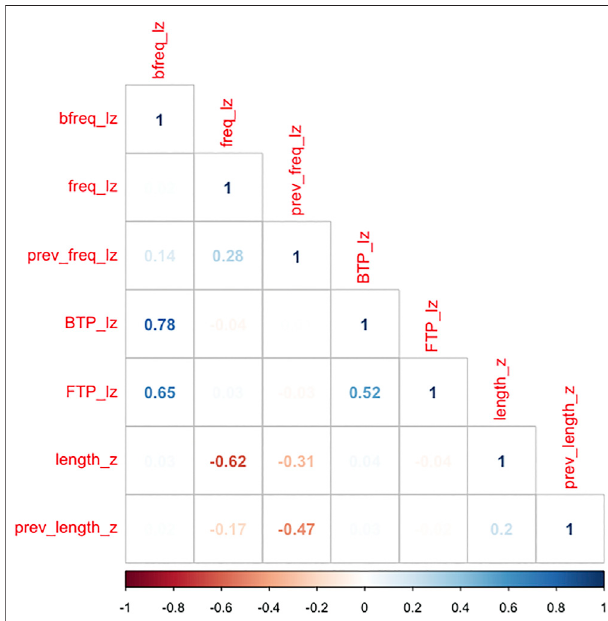
FIGURE 1 | Correlation between stimuli characteristics (Spearman ’ s ρ ): log-transformed bigram frequency (bfreq_lz), log-transformed current word frequency (freq_lz), log-transformed previous word frequency (prev_freq_lz), log-transformed backward transition probability (BTP_lz), log- transformed forward transition probability (FTP_lz), current word length in number of characters (length_z) and previous word length in number of characters